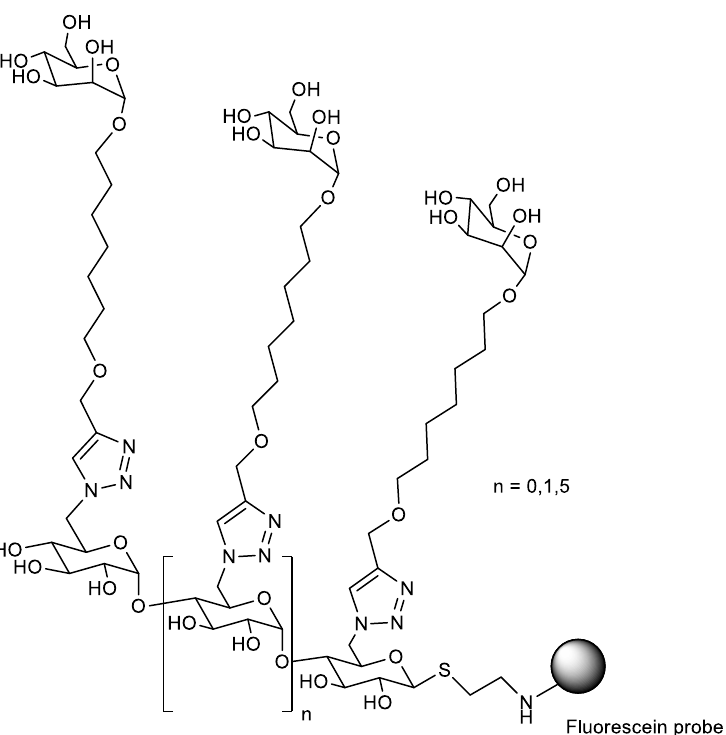
Scheme 23. Chemical structure of the HM